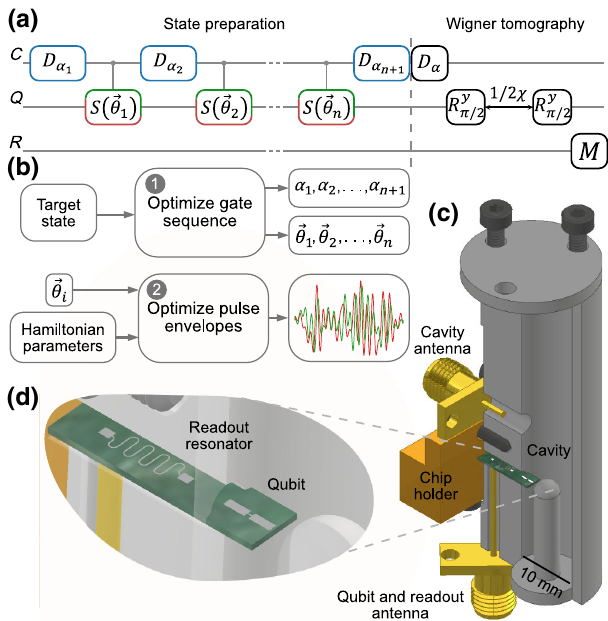
FIG. 1. (a) Pulse sequence used to prepare and characterize the states. By C , Q , and R we denote the cavity, qubit, and read- are the displacement gates out resonator, respectively. The D α i are cavity-state- and the S ( (cid:2) θ i ) are the SNAP gates. The R y π/ 2 independent π/ 2 pulses. They are separated in time by 1 / 2 χ , where χ is the dispersive shift between the qubit and the cavity. Here M is the measurement pulse. (b) The two steps of opti- mization that we perform to find the desired displacement and SNAP gates. (c) Drawing of the stub geometry cavity coupled to the transmon qubit. (d) Enlarged view of the chip containing the stripline readout resonator and the transmon